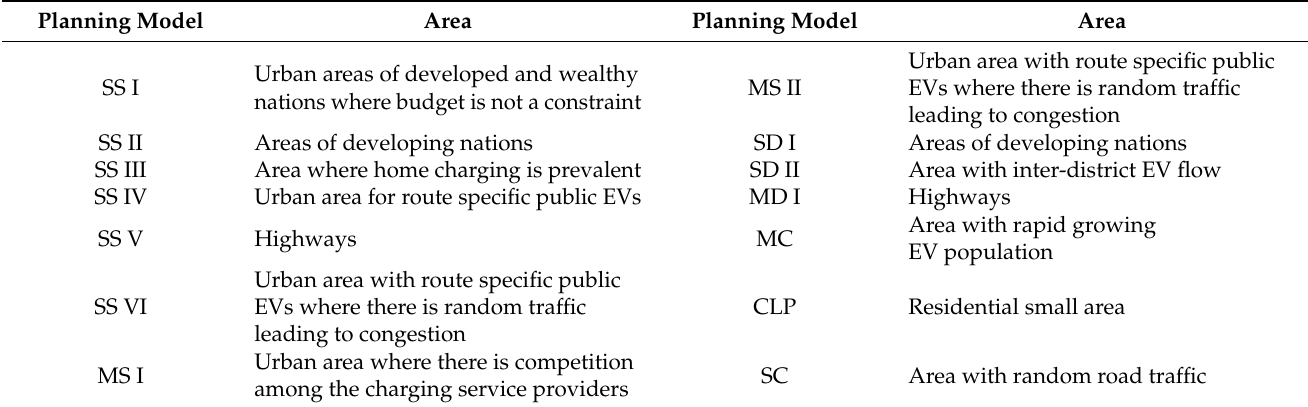
Table 9. Area wise suitability of Planning